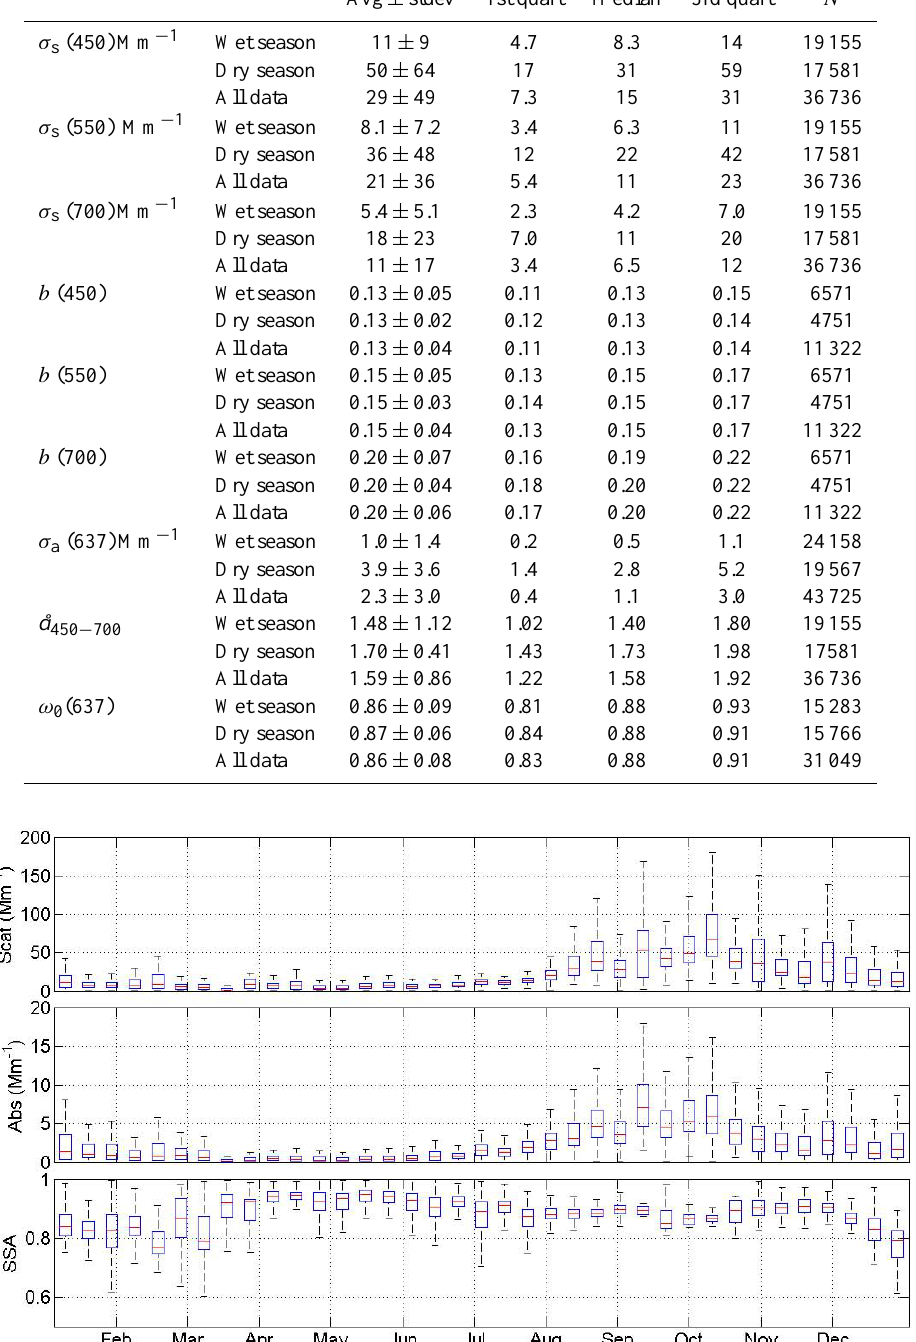
Fig. 7. Median 2008–2011 seasonal cycle for particle scattering coefficients at 550nm, particle absorption coefficients at 637nm, and particle single scattering albedo (SSA) at 637nm. Statistics were calculated for each 10 Julian days. The box lines represent the lower quartile, median and upper quartile values. Whiskers extend within 1.5 times the interquartile